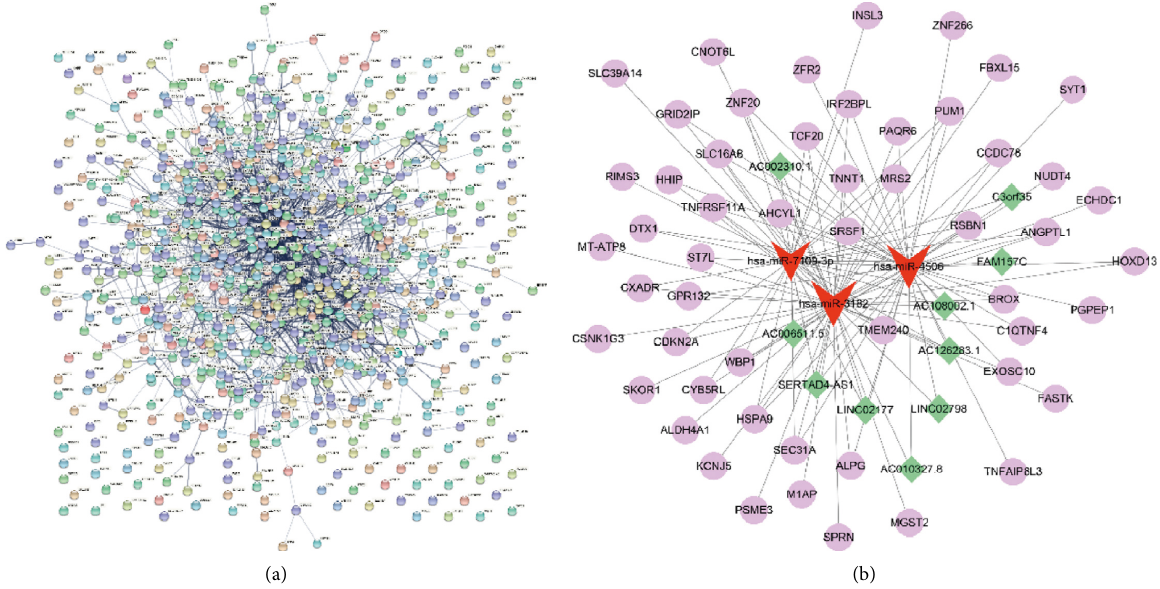
Figure 3: The lncRNA-miRNA-mRNA coexpression network analysis. (a) The PPI network of the DERmNAs. (b) The lncRNA-miRNA- mRNA network of RNAs with top degrees in each